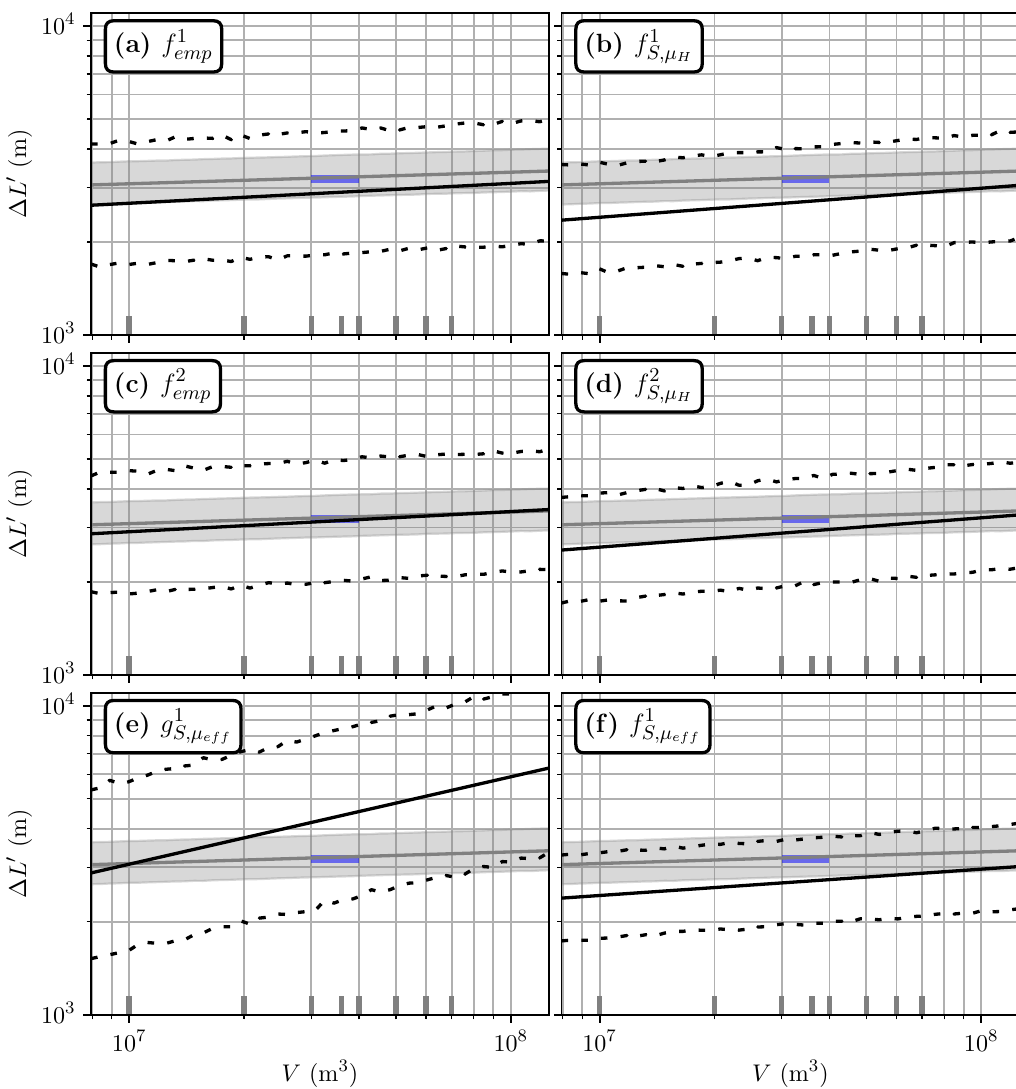
Figure 9. Travel distance estimated from volume for the Frank Slide case study. Blue rectangle: estimations of volumes and travel distances for 1903 slide the documented event. ( a – f ), and symbols are the same as for Figure